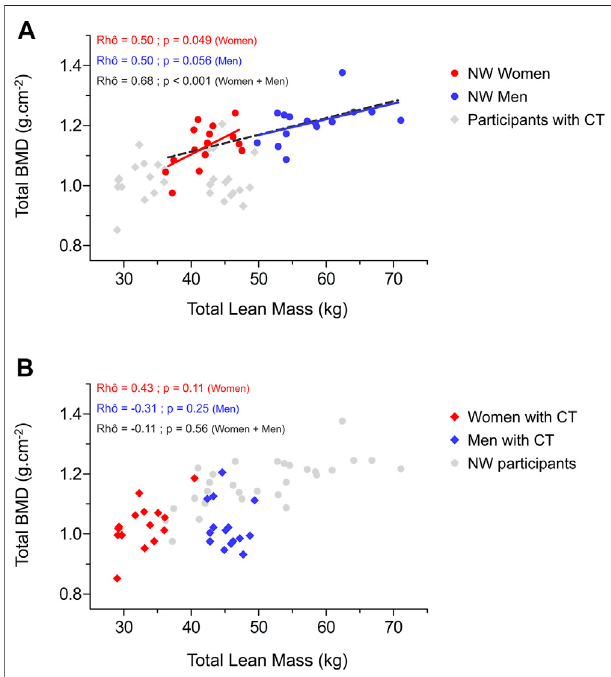
FIGURE 3 | Relationship between total bone mineral density and total lean mass in normal weight women and men (A) and in women and men with constitutional thinness (B) . BMD, bone mineral density; CT, constitutional thinness; NW, normal weight.